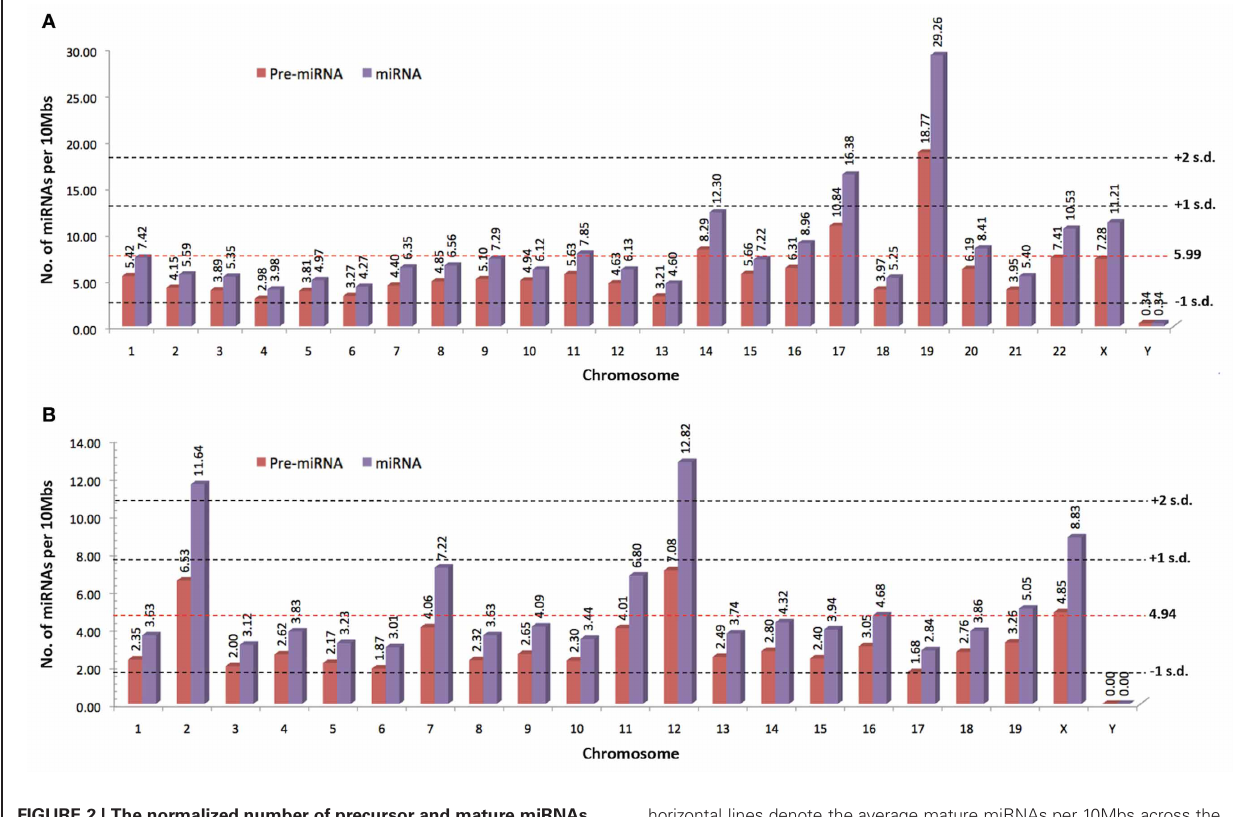
horizontal lines denote the average mature miRNAs per 10Mbs across the genome. Gray-dotted horizontal lines denote the number of standard deviation (SD) from the global average